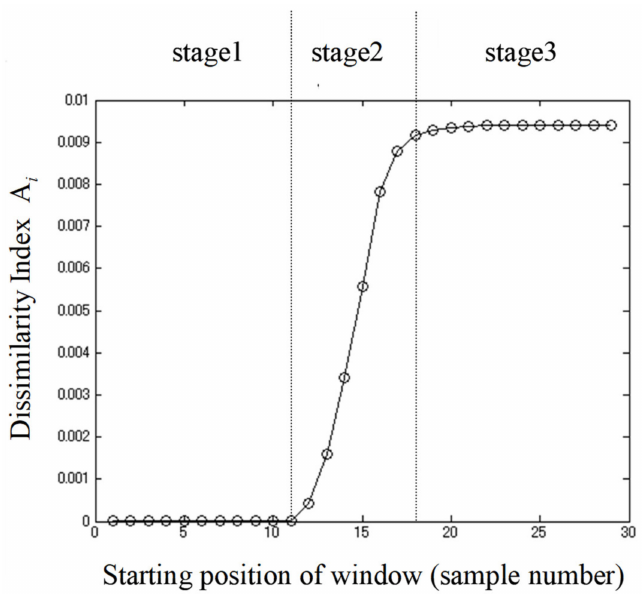
Figure 4. Dissimilarity Index A i based on loading variations of yogurt fermentation time (X-axis indicates the starting position of the window).